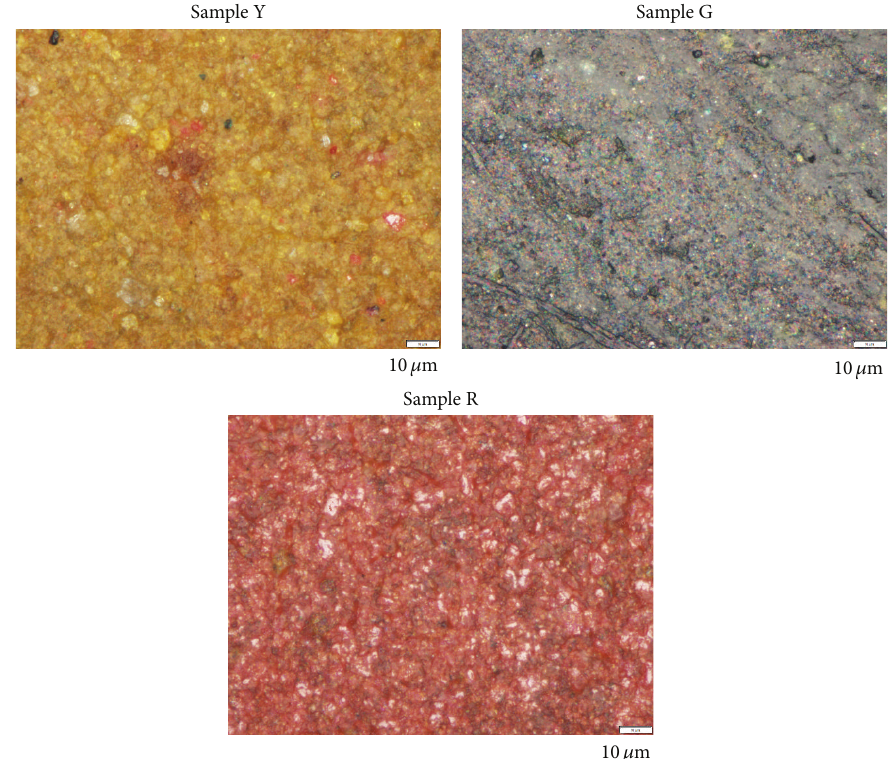
Figure 2: Microphotographs showing surface conditions of Samples Y, G, and R.